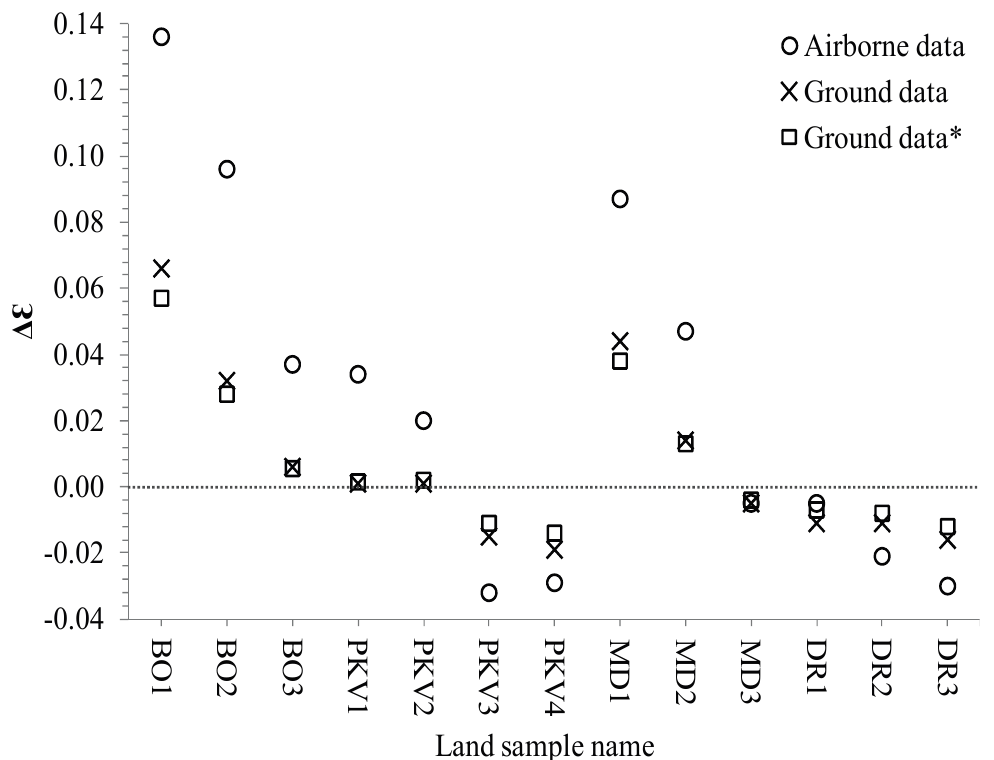
Figure 8. The ΔԐ values of land samples as calculated from the airborne data and from the ground data. * Ground ΔԐ values marked with □ symbols, as opposed to those marked with X symbols, were calculated by neglecting the reflected down-welling radiance, as done with the airborne data. Both series of ground ΔԐ values are